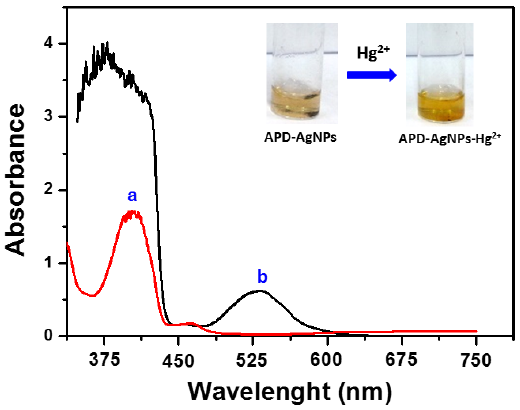
Figure 2. Absorption spectra showing ( a ) SRP bands of APD-AgNPs and ( b ) APD-AgNPs-Hg 2+ complex. Inset image showing colorimetric digital picture of APD-AgNPs and APD-AgNPs-Hg 2+